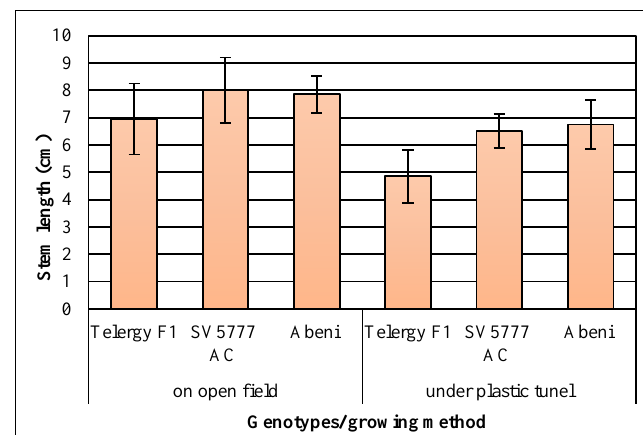
Figure 1. Results of stem, leaves and weight of curd by different cauliflower genotypes and growing method (n=10; Nagykereki, 2018)